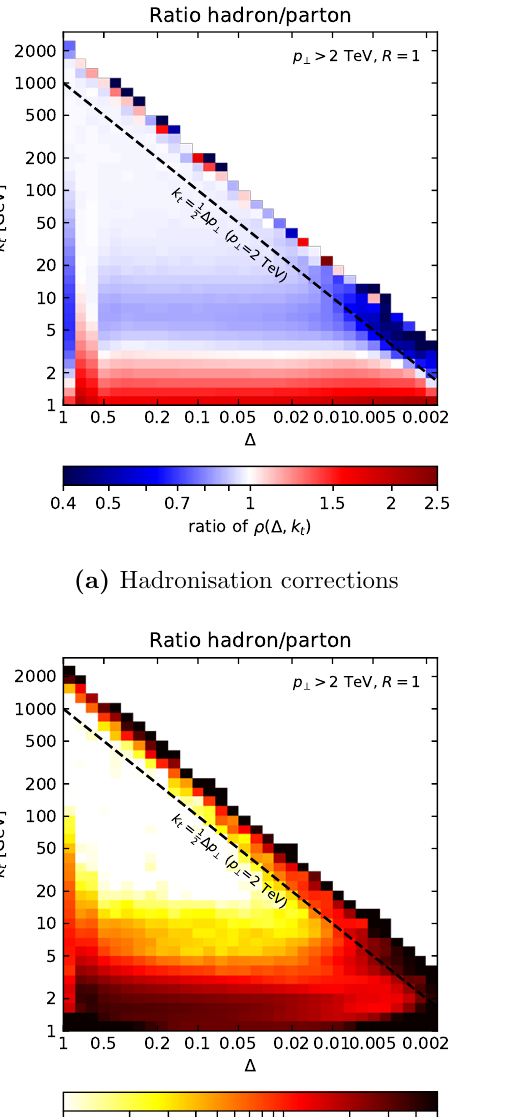
p ? (cid:1), for jets with p ? = 2 2